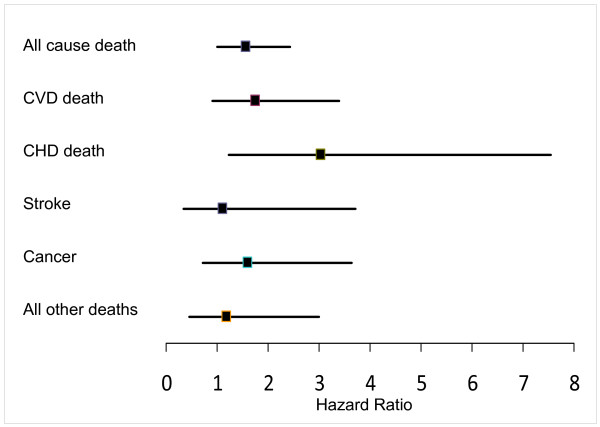
Adjusted hazards ratios and 95% confidence interval of mortality in SOF participants with blood lead concentrations ≥ 8 μg/dL (≥ 0.384 μmol/L). Adjusted hazard ratios and 95% confidence interval of all cause mortality and cause specific mortality in SOF lead ancillary study participants with blood lead concentrations ≥ 8 μg/dL (≥ 0.384 μmol/L), compared to referent < 8 μg/dL (< 0.384 μmol/L),